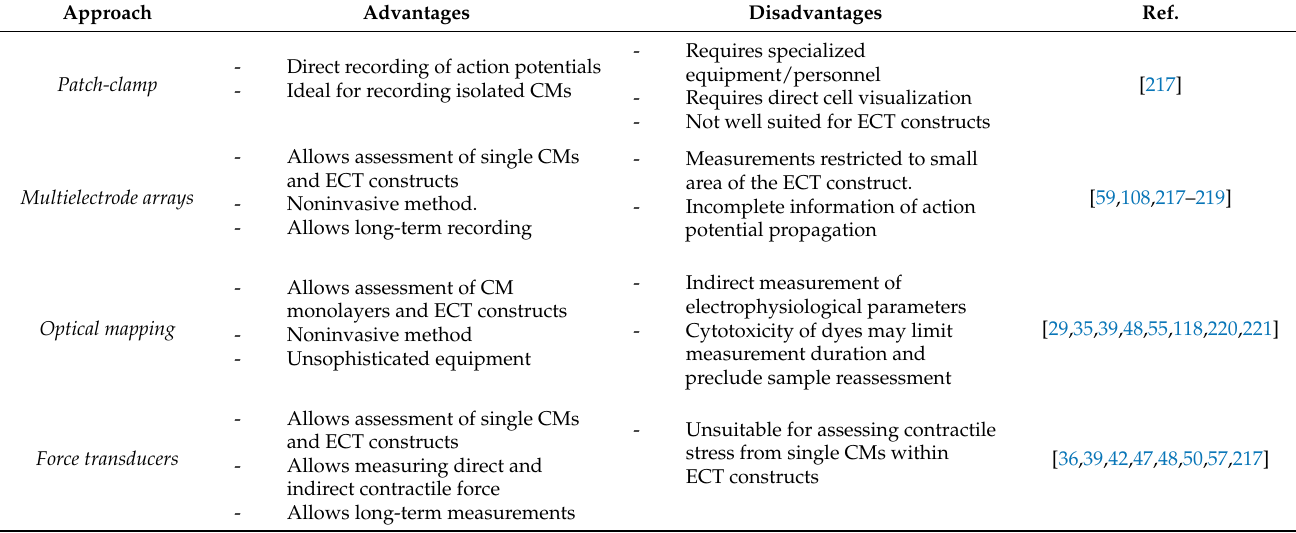
Table 2. Main approaches to functional assessment of ECT